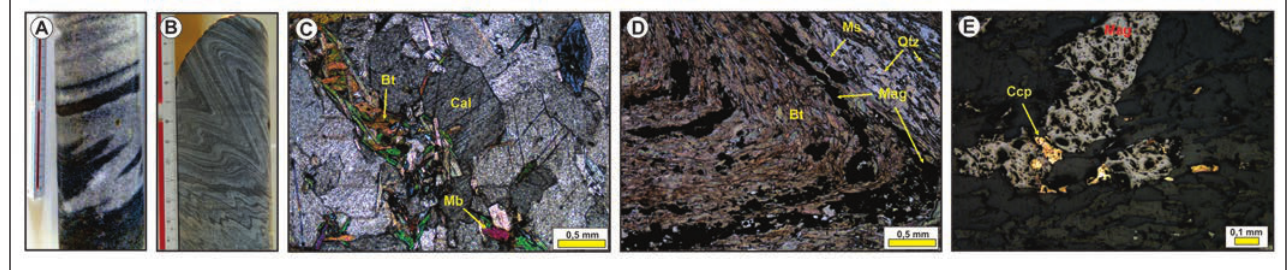
Figure 6 - Petrography of the upper compartment (Jucurutu Formation) units: (A) marble drill core showing interdigitation of light and dark gray beds; (B) chevron-like folds in drill-core of the banded iron formation; (C) photomicrograph of marble formed by calcite, biotite and muscovite (crossed Nicols); (D) photomicrograph of the banded iron formation evidencing a hinge zone of a tight fold delineated by alternating quartz+phyllosilicates and magnetite (parallel Nicols); (E) magnetite crystal with chalcopyrite at the edges (reflected light). Bt = biotite, Cal = calcite, Ccp = chalcopyrite, Mag = magnetite, Mb = white mica, Qtz = quartz.